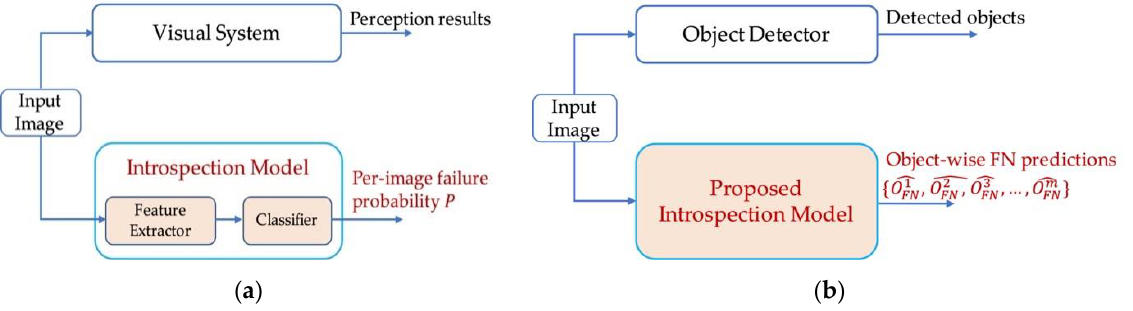
Figure 3. Original concept of introspection and our extension. ( a ) Original concept of introspection. Failure features are extracted and classified to obtain a per-image failure probability 𝑃 ; ( b ) Our extension of introspection. The concept of introspection is extended to perform object-wise failure predictions in our work, 𝑂 𝐹𝑁 𝑚 ̂ refers to the 𝑚 th predicted FN ob- ject in the input image.